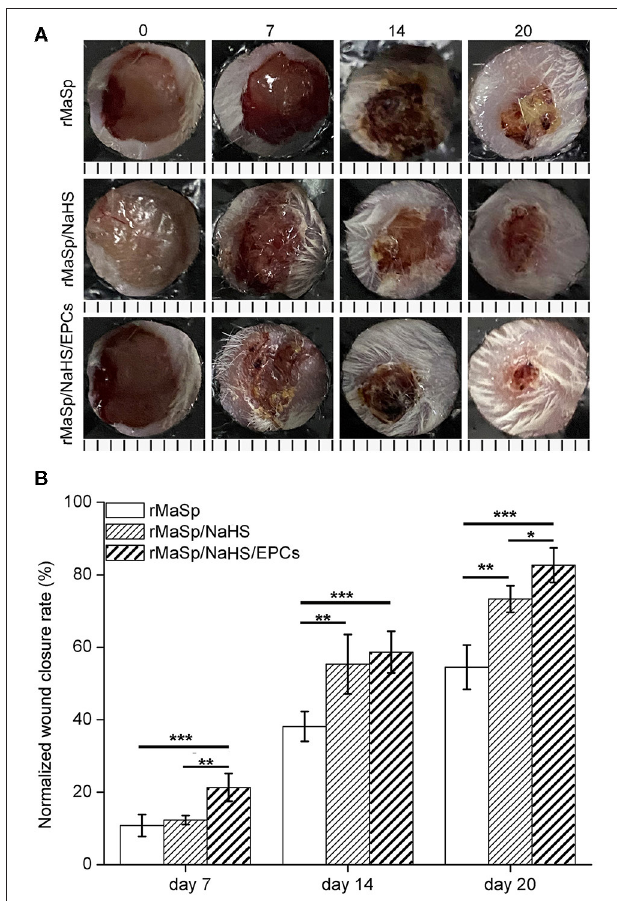
FIGURE 7 | Wound closure upon treating with rMaSp membrane, rMaSP/NaHS membrane, and rMaSP/NaHS/EPC membrane. (A) Macroscopic observation of wounds covered with membranes on days 0, 7, 14, and 20. The unit of the rulers under the pictures is mm. (B) Wound closure rates of treated wounds. The statistical differences were performed using ANOVA. * p < 0.05, ** p < 0.01, *** p < 0.001 compared with the control group, n =